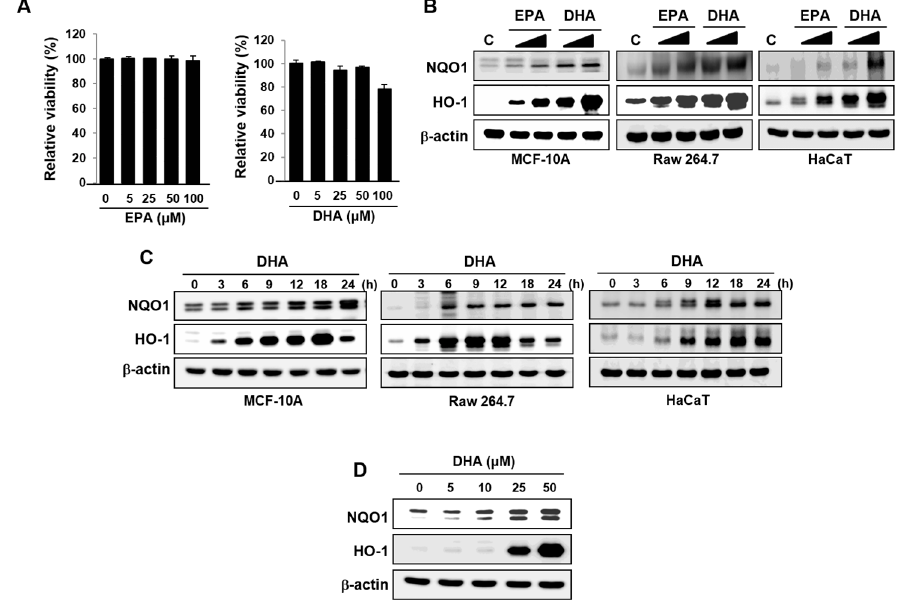
Figure 1. Effects of DHA on the expression of HO-1 and NQO1. ( A ) MCF-10A cells were treated with EPA or DHA for 48 h with indicated concentrations. Cell viability was determined in triplicate by the MTT assay. Columns, means (n = 3); bars, standard deviation (SD). ( B ) MCF-10A, Raw 264.7, or HaCaT cells were incubated with EPA or DHA (25 or 50 μ M) for 18 h. Whole cell lysates were subjected to Western blot analysis. ( C ) MCF-10A, Raw 264.7, or HaCaT cells exposed to DHA (25 μ M) were harvested at the indicated intervals, and the protein expression was assessed by Western blot analysis; ( D ) MCF-10A cells were treated with indicated concentrations of DHA for 18 h, and the expression levels of HO-1 and NQO1 were measured by Western blot analysis.